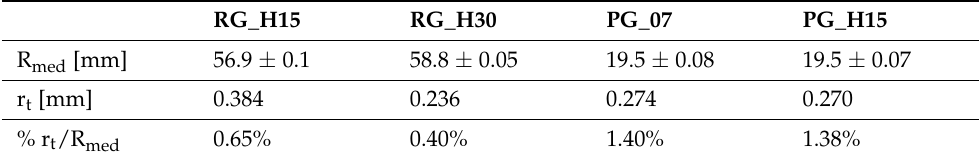
( c ) scale bar Figure 9. Fillet radius morphology of ( a ) real and ( b ) prototype geometry with ( c ) scale bar.